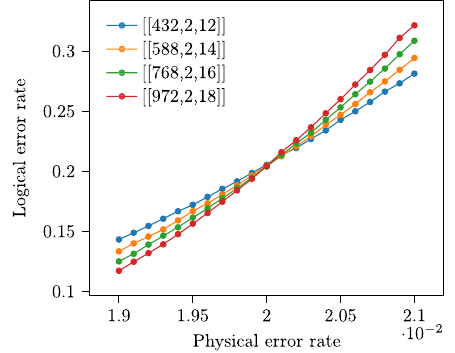
FIG. 30. Subsystem toric code threshold with a phenomeno- logical noise model, and without using gauge fixing (triangular lattice-matching graph). Using the critical exponent method, we find a threshold of 0.02004(2).